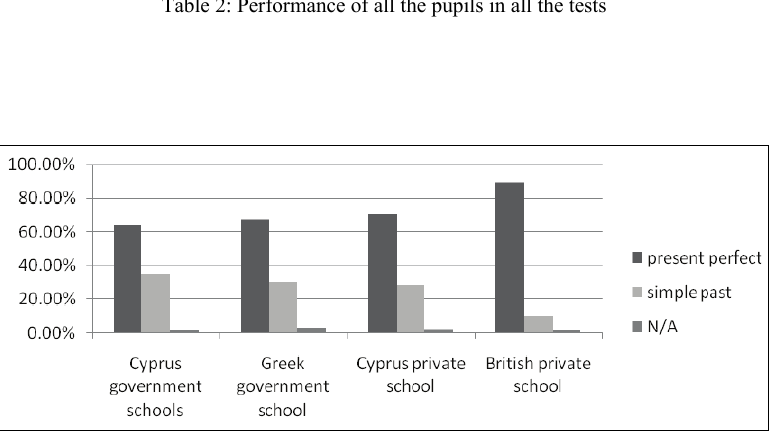
Figure 1: Performance of all the pupils in all the